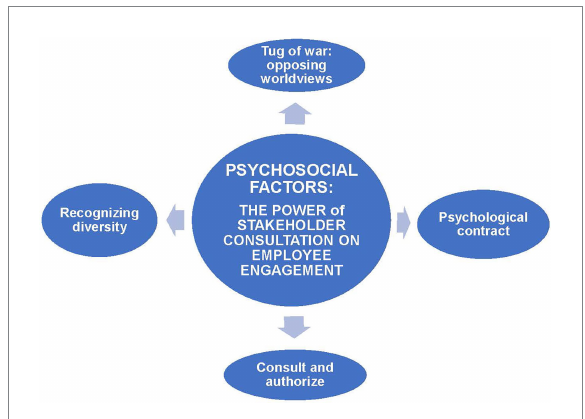
FIGURE 2 Psychosocial factors: The power of stakeholder consultation on employee